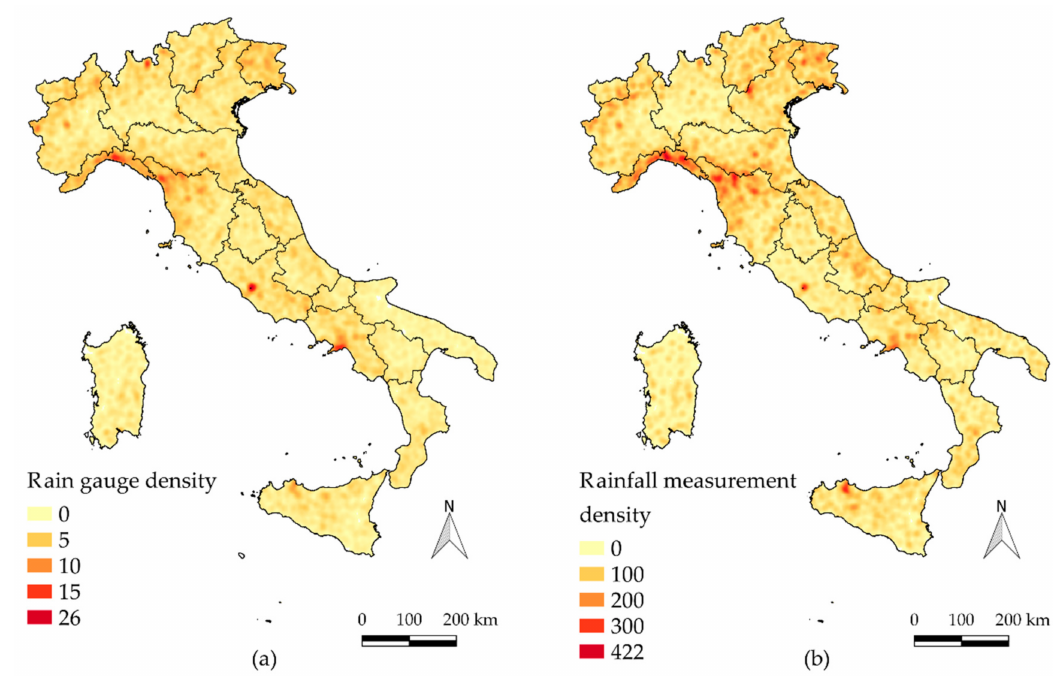
Figure 6. ( a ) Kernel density map (obtained using QGIS Heatmap Plugin) with a spatial resolution of 2 × 2 km. The colors refer to the number of rain gauges available within a 10 km radius centered in each cell. ( b ) Kernel density map obtained with a distance equal to 10 km, spatial resolution of 2 × 2 km, and weighted with the length of the time series. The colors refer to the number of measurements (i.e., the sum of the lengths of all the time series available within a 10 km radius centered in each